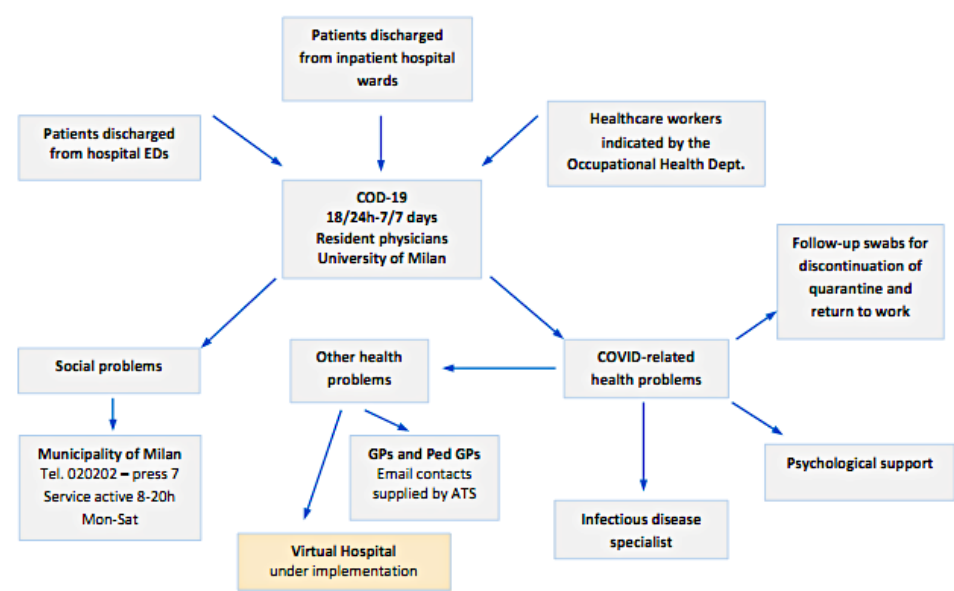
Figure 1. General overview of the Operations Center for Discharged Patients (COD19).